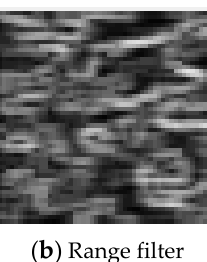
Figure 6. The results of preprocessing: ( a ) histogram equalization; ( b ) range filter. After the preprocessing of US images, texture statistical features were extracted using the GLCM algorithm. Means of features were obtained using the GLCM relative to four